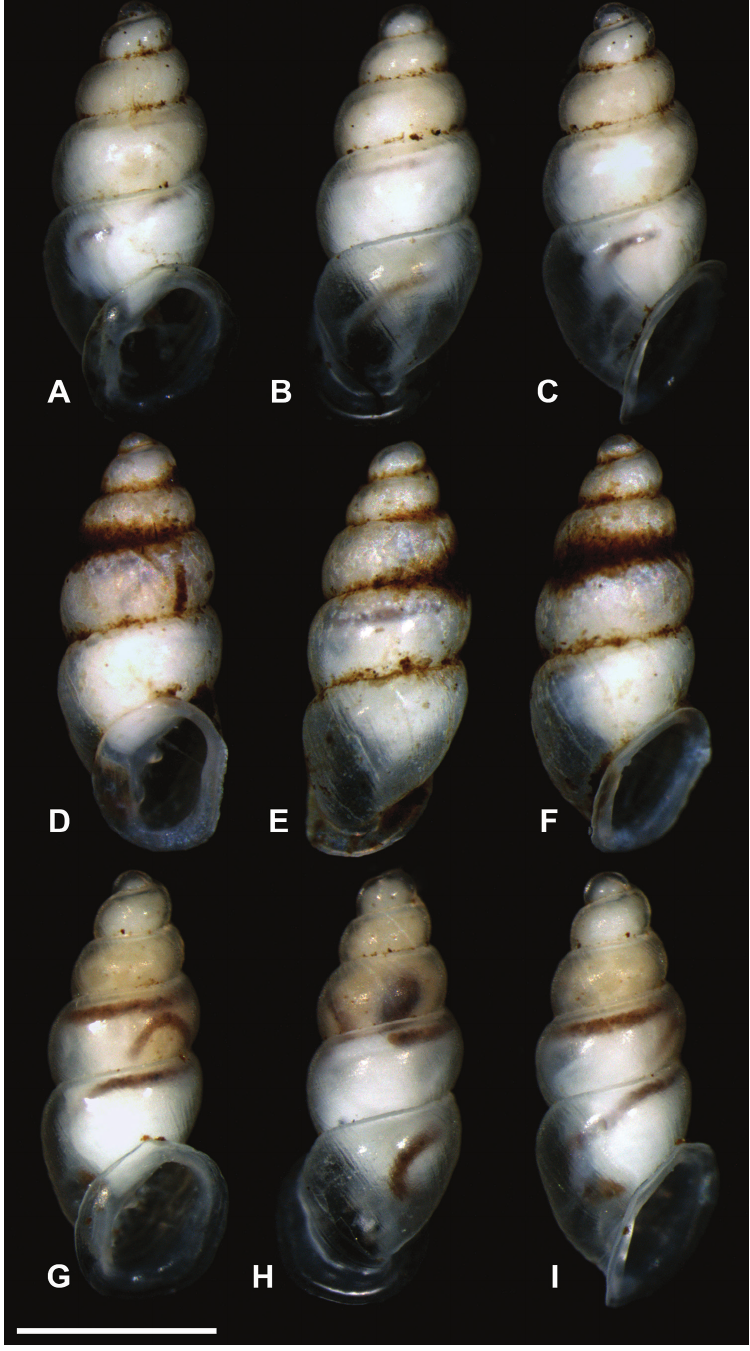
Figure 15. Evolutionary Lineage (EL) C12 (Weigand et al. 2013). A–I Panamanian snails before se- quence procedures. Scale bar 1